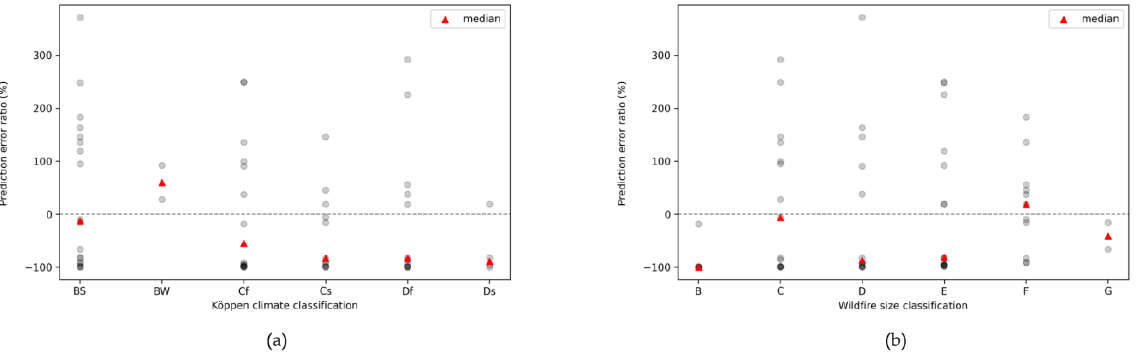
Figure 12. The simulation results on the evaluation on the performance of the proposed hybrid modeling scheme. ( a ) Prediction error ratio for a hybrid model trained with a feature-based selected training data compared a hybrid model trained with a randomly selected training data on Köppen climates class, ( b ) Prediction error ratio for a hybrid model trained with a feature-based selected training data compared a hybrid model trained with a randomly selected training data on initial wildfire size class.